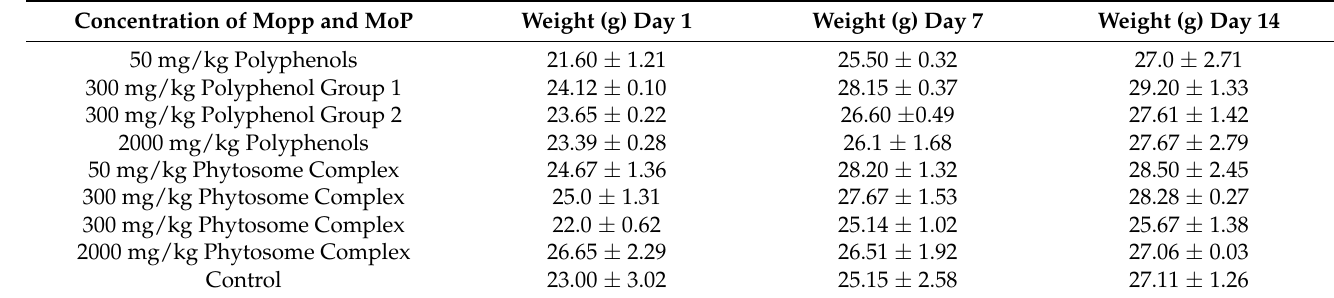
Table 6. The weight variation of Swiss albino female mice during the 14 days of free Mopp and MoP complex and control oral administration. The data are expressed as mean ±